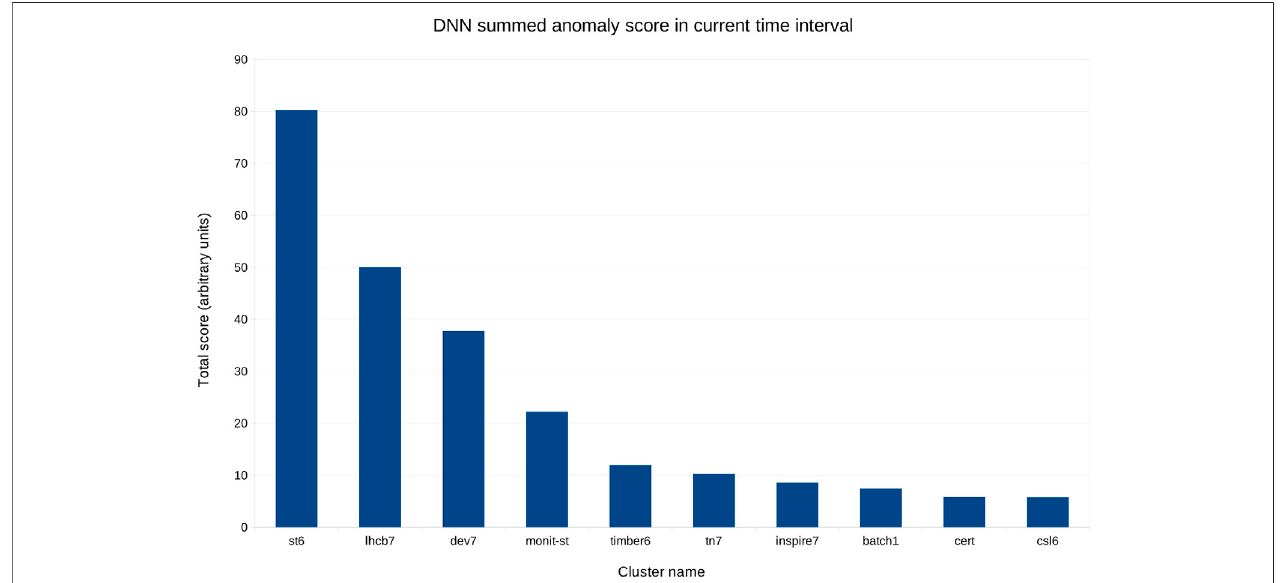
FIGURE 6 | Aggregated score for the same day as in Figure 5 , from 8am to 12pm, in decreasing order.